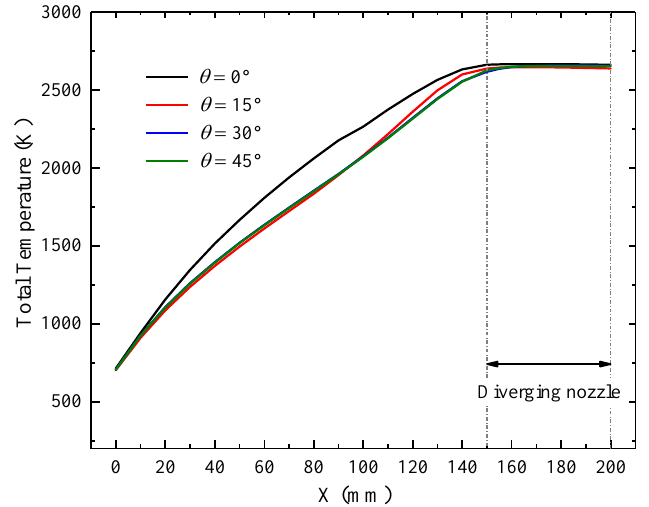
Figure 18. The averaged total temperature in different axial cross-sections of the RDC at t = 3980 μs.